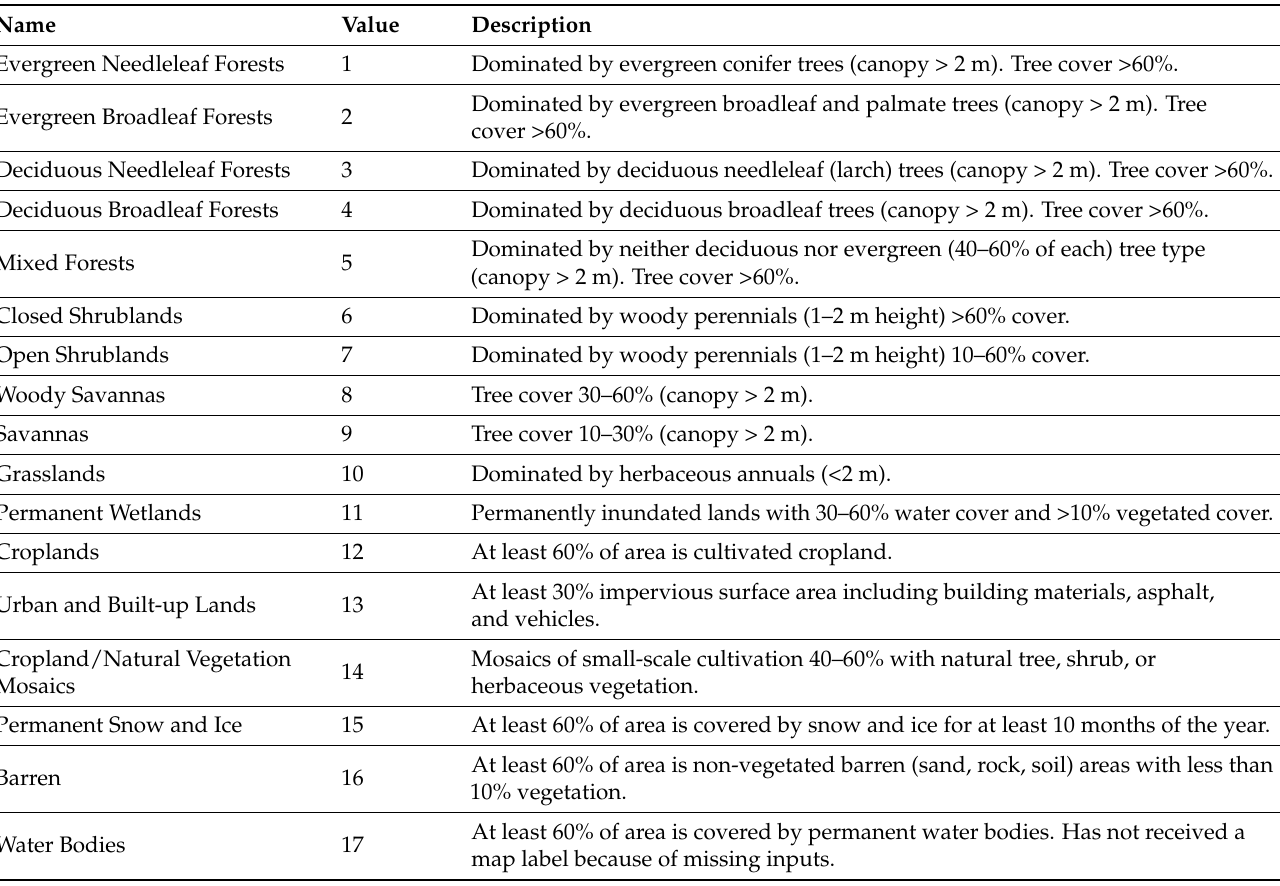
Table 1. IGBP land cover class